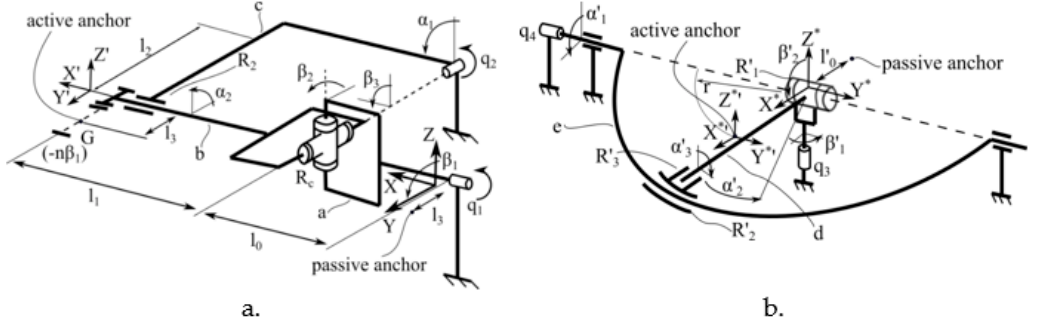
Figure 1. Kinematic scheme of the ParReEx robotic structure (( a ) kinematic scheme of the elbow rehabilitation module, ( b ) kinematic scheme of the wrist rehabilitation module) [37].